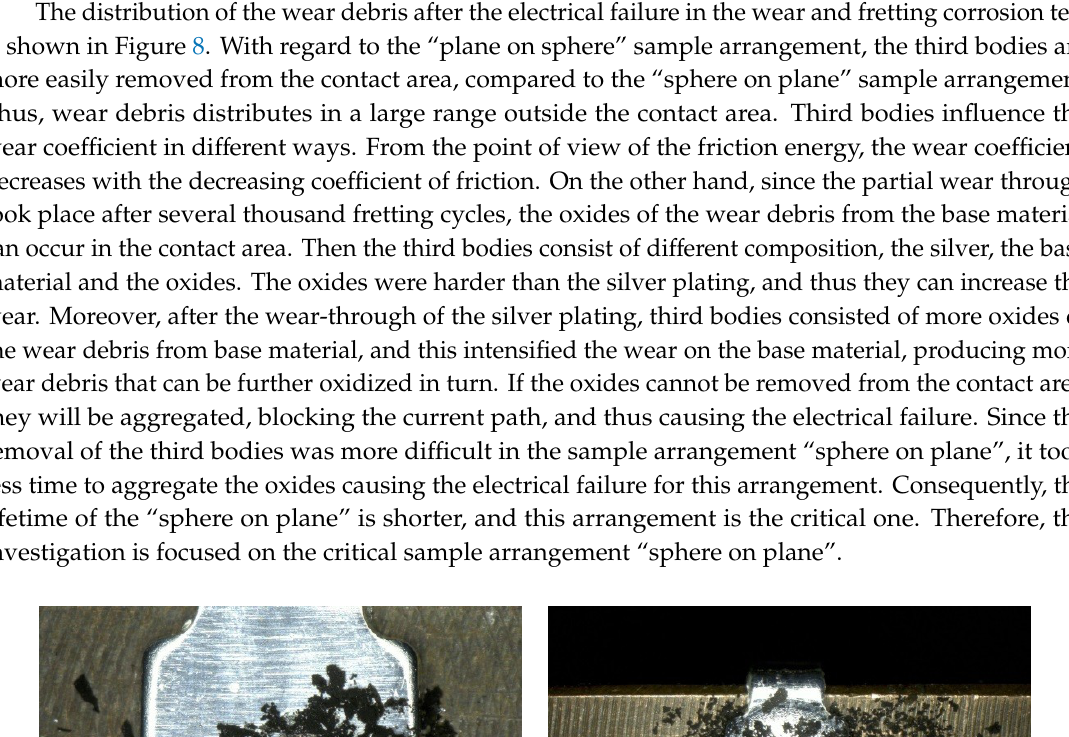
Figure 9. Thickness reduction of the spherical parts with “sphere on plane” arrangement.